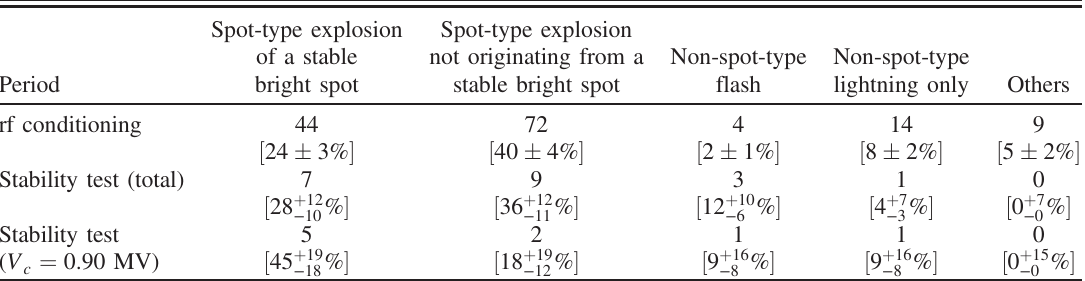
TABLE IV. Classification of the cavity breakdown events according to the phenomenon observed by the TV cameras at the moment of cavity breakdown. Numbers enclosed in square brackets are percentages of the total numbers of cavity breakdown events with binomial errors for a 1 σ confidence interval. Examples of cavity breakdown events classified as the “ spot-type explosion of a stable bright spot ” , “ spot-type explosion not originating from a stable bright spot ” , “ non-spot-type flash ” , and “ non-spot-type lightning only ” columns are shown in Figs. 9, 12, 16(b), and 16(c) and (d), respectively. Detailed definitions of these event types are given in Sec. IVA.